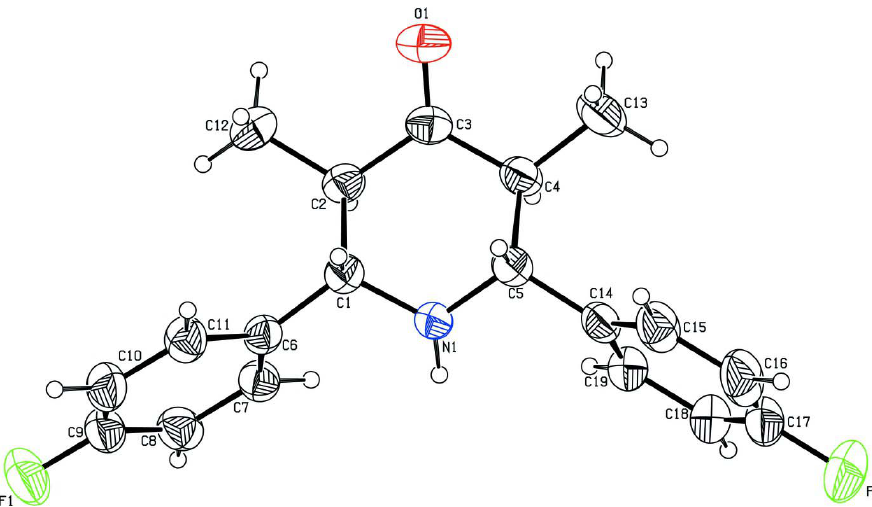
Figure 1 The molecular structure of title compound, showing 30% probability displacement ellipsoids.